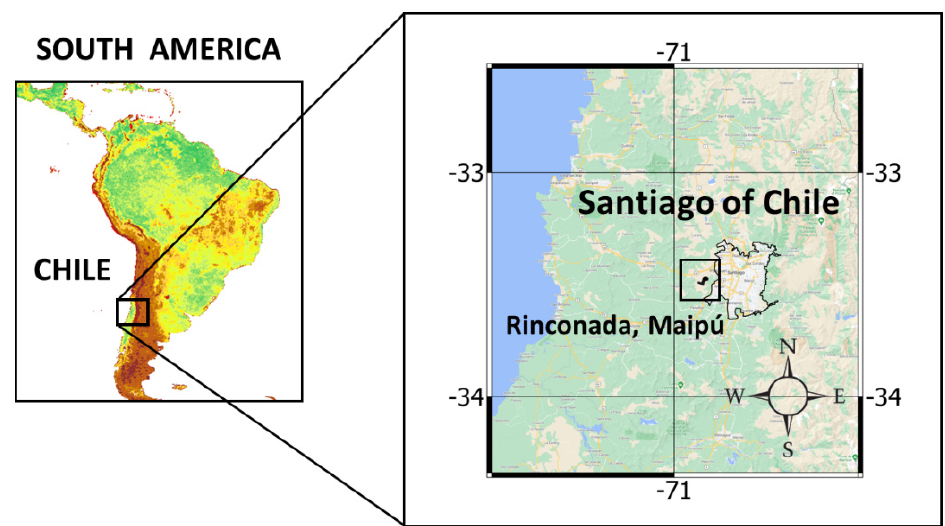
Figure 1. Location of the area where the study was carried out.